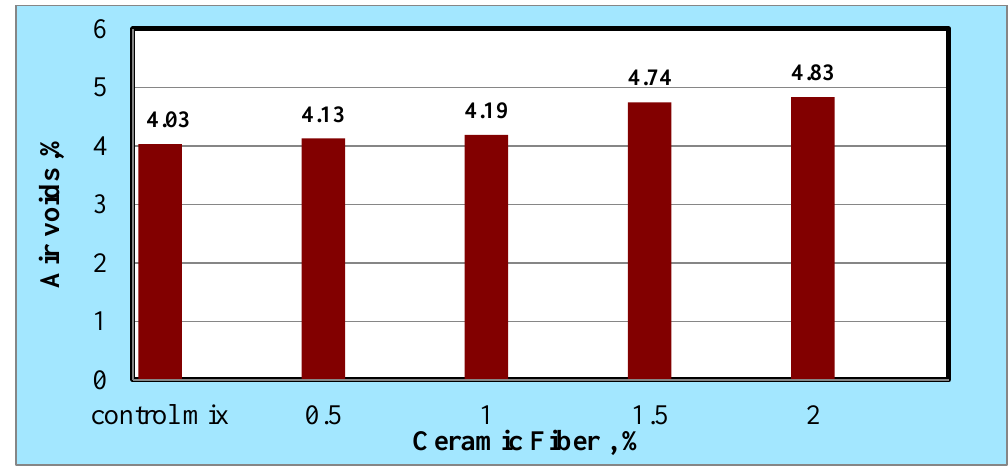
Fig. 5. Effect of Ceramic Fiber on Air Voids of Asphalt Mixture.